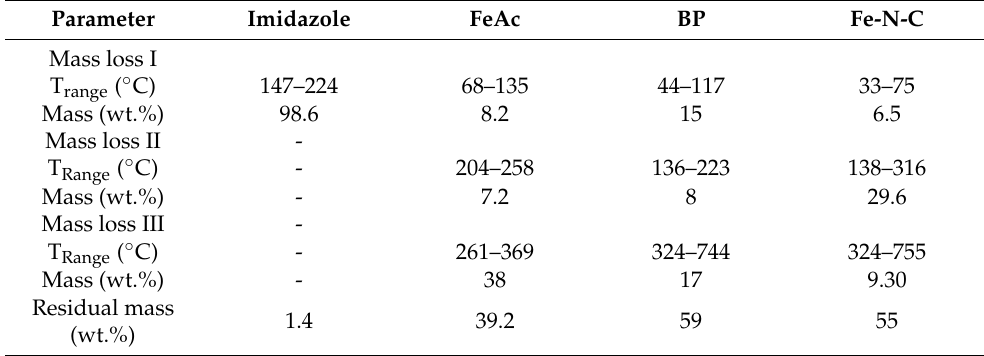
Table 1. Temperature range (T Range ) and the corresponding mass loss (wt.%) from TG curves. Parameter Imidazole FeAc